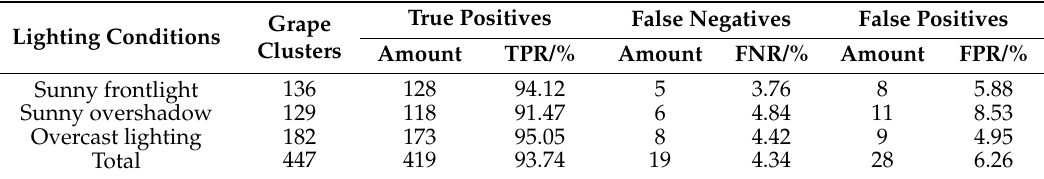
Table 3. The detection results of the proposed method.